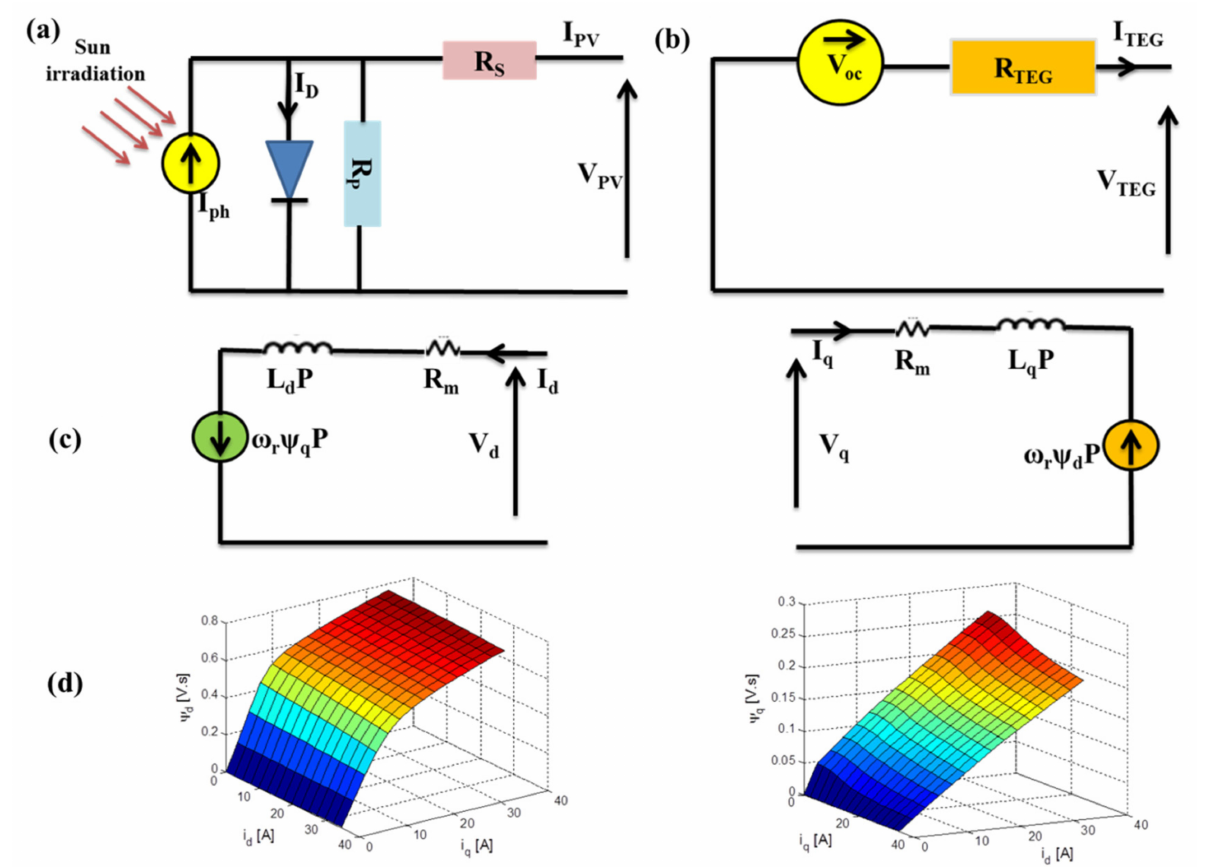
Figure 5. ( a ) The perovskite solar cell single diode model. ( b ) The TEG equivalent model. ( c ) The dq axis equivalent circuit of SynRM. ( d ) SynRM flux-linkages along the dq -axis as a relation in dq -axis current